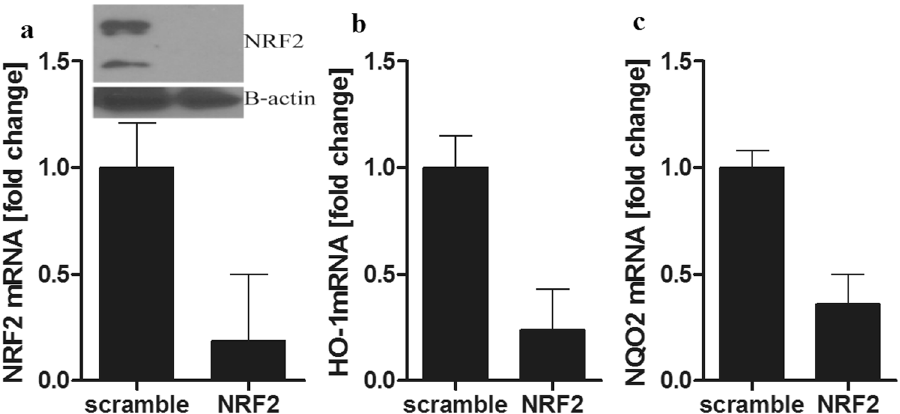
Figure 6. Silencing of the NRF2 in human melanocytes reduced the effect of melatonin on the expression of NRF2 and NRF2-related genes: HO-1 and NQO2. Melanocytes were transfected with scrambled or NRF2 siRNA and treated with 5 × 10 − 5 M melatonin. Cells were lysed after treatment and total RNA extracted. NRF2 mRNA ( a ), HO-1 mRNA ( b ) and NQO2 ( c ) levels were measured using reagents for RTPCR and normalized relative to B-actin RNA. Levels of NRF2 and B-actin were assessed 72 h after transfection with NRF2 or scrambled siRNA, by western blotting of whole-cell extracts